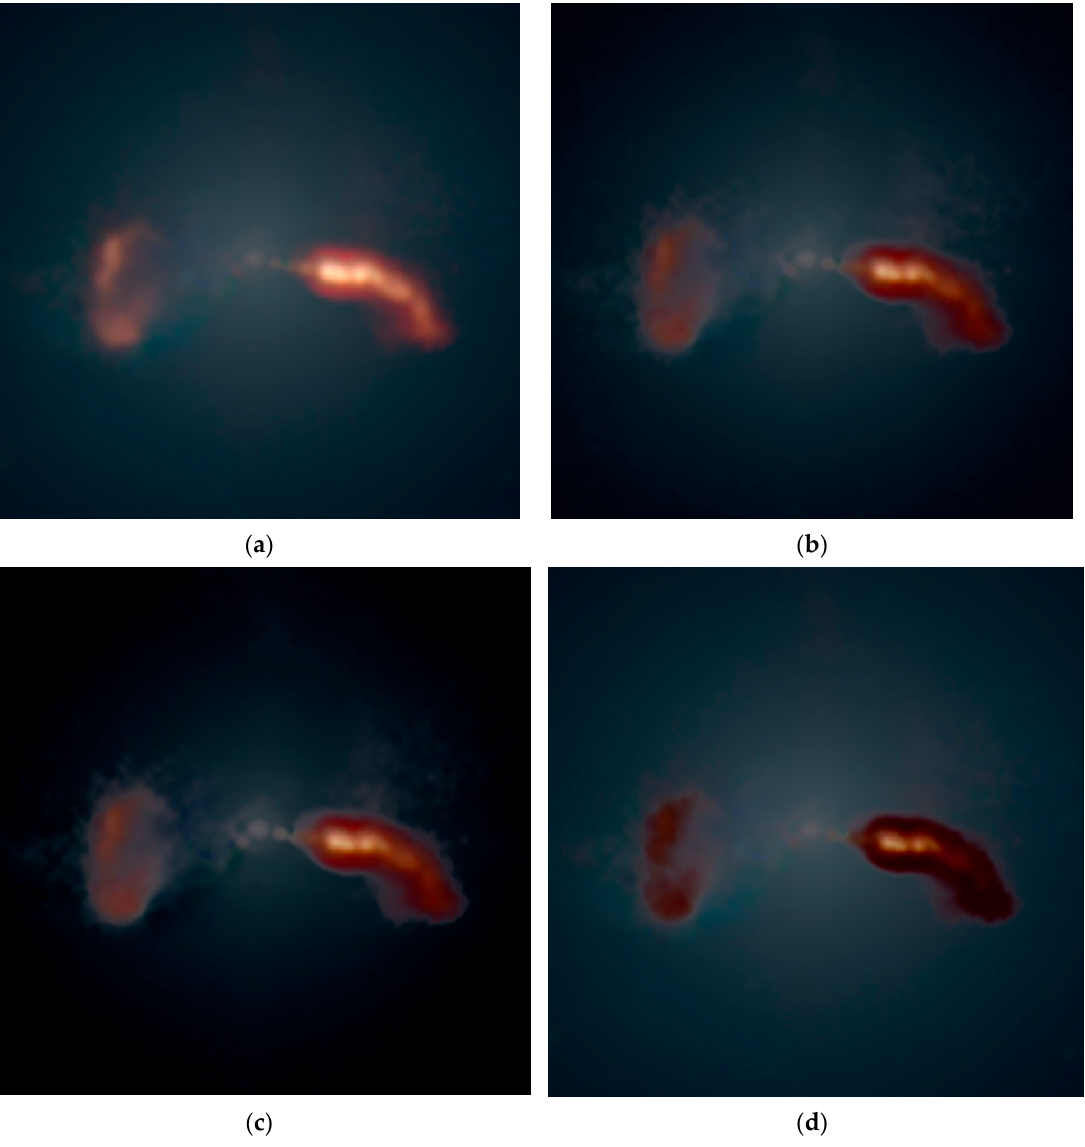
Figure 5. Cropped images of ( a ) original image, credited to NASA/IPL-Caltech/IPAC, ( b ) 22 nd ISED-generated image, ( c ) 23 rd ISED-generated image, and ( d ) the 24 th ISED-generated image.